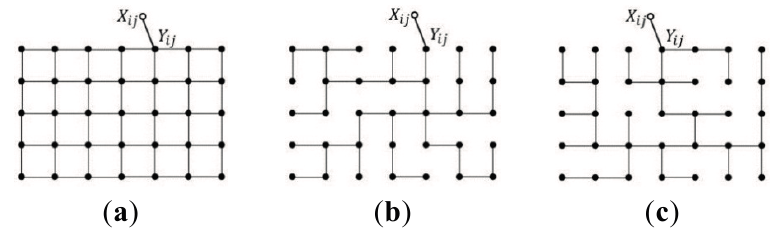
Figure 3. Illustration of a 5 × 7 grid-like CRF graph ( a ) and corresponding two randomly generated spanning trees ( b , c ). In CRF setup in computer vision, the observation variable could be the average color of the pixel patch, and the random variable (cid:1851) (cid:1850) (cid:3036)(cid:3037) a classification label of the pixel patch. For clarity we show only one pair of (cid:1850)